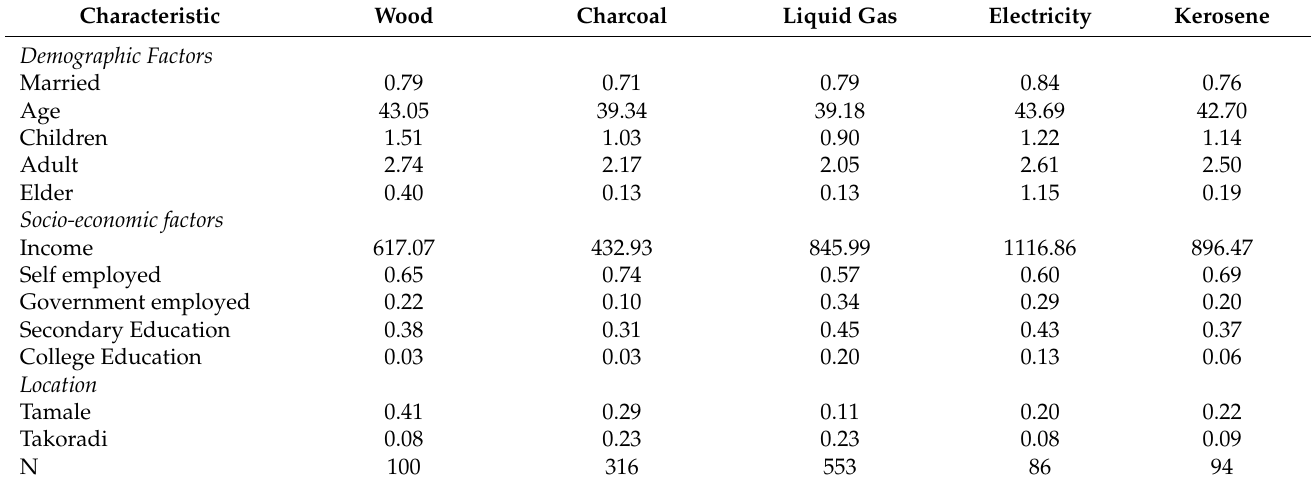
Table 3. Consumer profiles based on the survey results associated with the frequency use of each cooking fuel “often” or “very